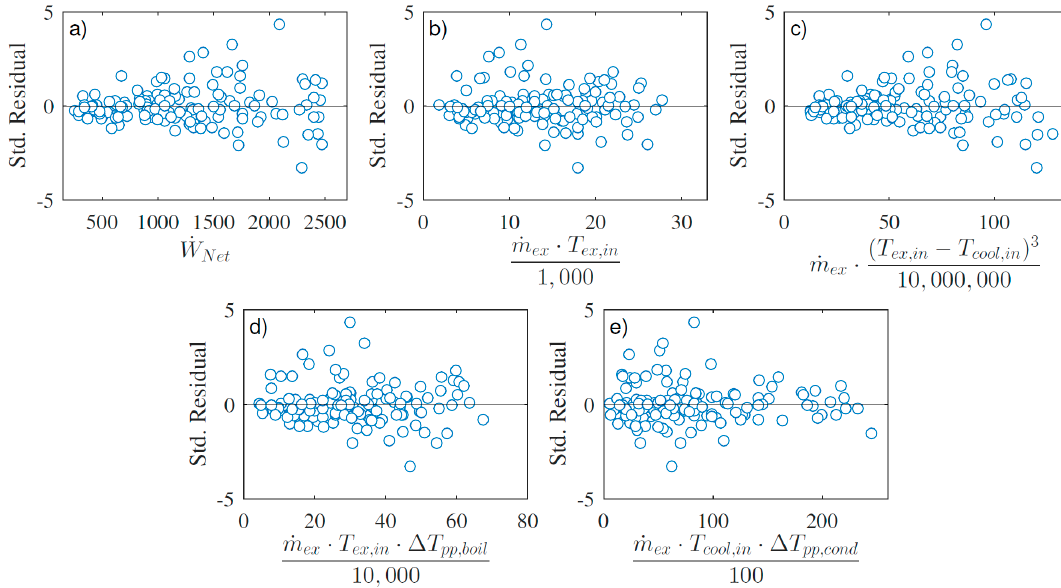
Figure 8. Design regression model #2, standard residuals distribution according to the target data and regression parameters.